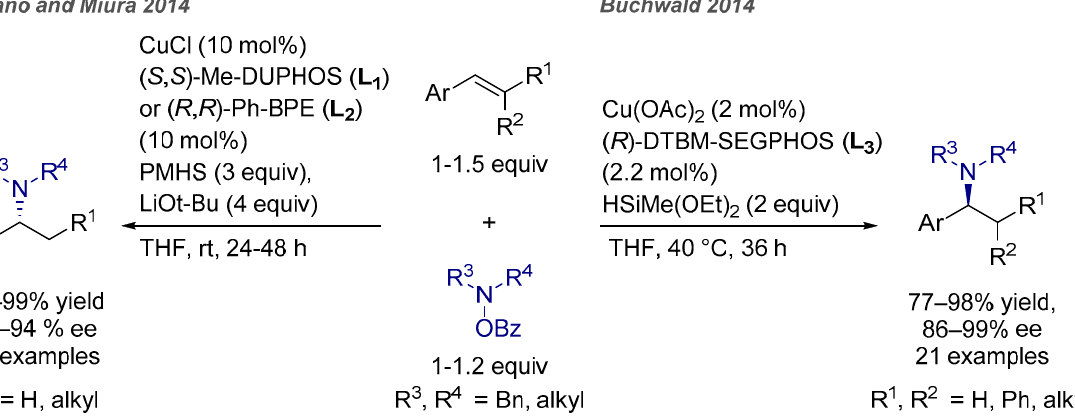
Figure 24. Regio- and enantioselective CuH-catalyzed hydroamination of arylalkenes with hydroxylamine esters. ee = enan- tiomeric